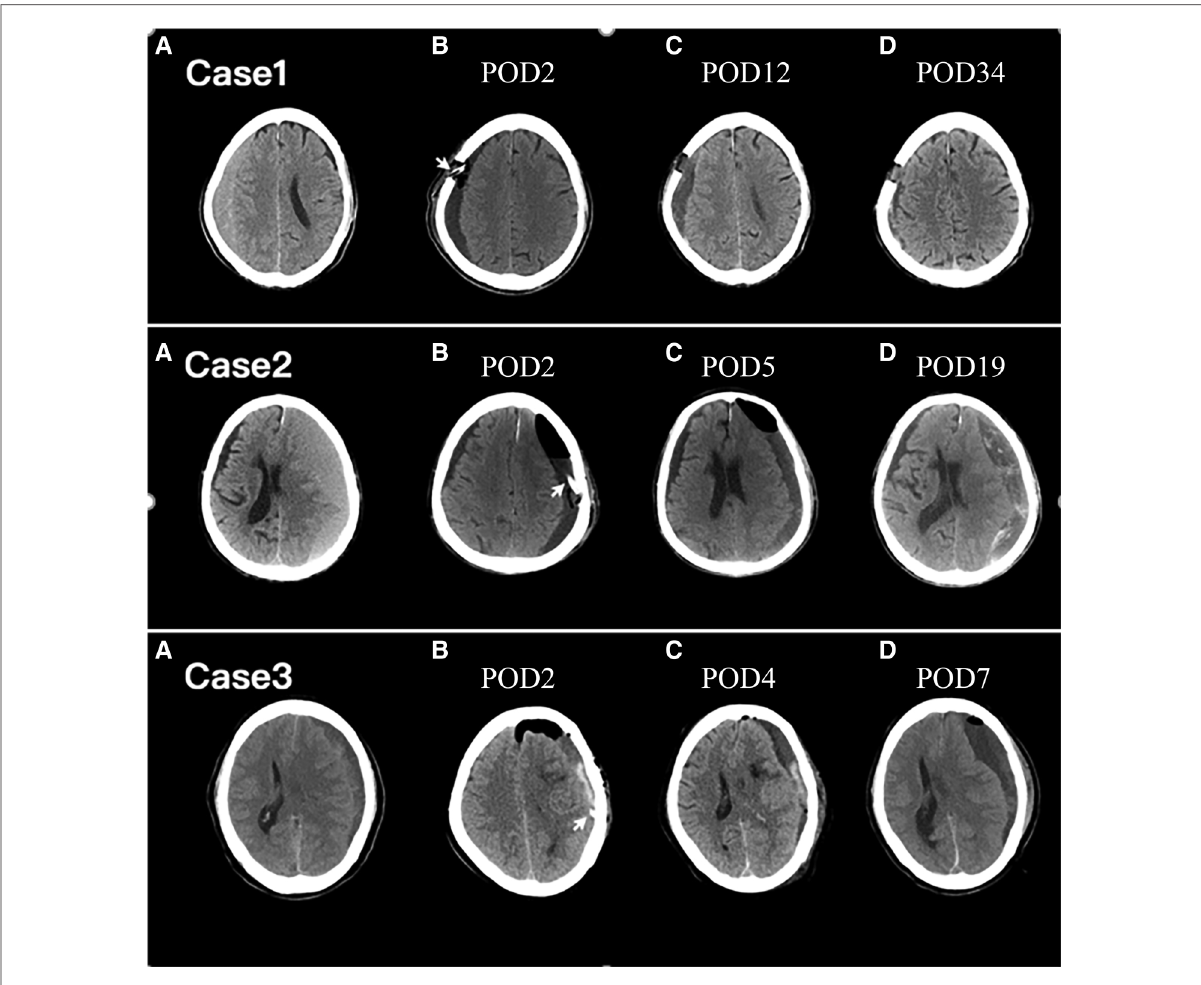
FIGURE 4 Axial CT images of representative cases. The arrowhead points to the drain tube. POD, postoperative day; Upper row: Case 1. Preoperative CT image ( A ) showing right-lateralized CSDH. Serial CT images were obtained on POD 2 ( B ), POD 12 ( C ), and POD 34 ( D ). A homogenous hypo-density type was exhibited on POD 2 ( B ). A hybrid-density type was exhibited at POD 12 ( C ) and the residual hematoma was almost completely reabsorption at POD 34 ( D ). Middle row: Case 2. Preoperative CT image ( A ) showing left-lateralized CSDH. Serial CT images were obtained on POD 2 ( B ), POD 5 ( C ), and POD 19 ( D ). A homogenous hypo-density type was exhibited on POD 2 ( B ). A hybrid-density type was exhibited at POD 5 ( C ). On POD 19, the residual hematoma was expanded and the recurrence happened ( D ). Lower row: Case 3. Preoperative CT image ( A ) showing left-lateralized CSDH. Serial CT images were obtained on POD 2 ( B ), POD 4 ( C ), and POD 7 ( D ). A layer of high CT density in the residual hematoma is demonstrated on POD 2 ( B ). On POD 4, the residual air was almost completely absorbed and the high-density component of the residual hematoma faded ( C ). CSDH recurrence occurred on POD 7 ( D